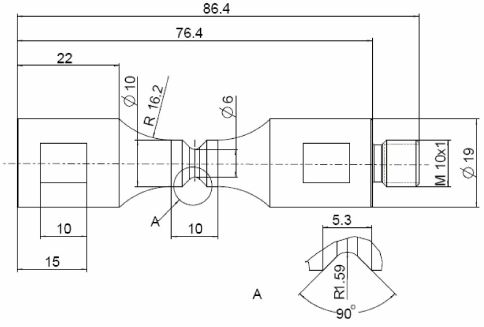
Figure 3. Geometry of ultrasonic testing system (USP) specimens with ultimate tensile strength 919 MPa and K = 1.75 [6], VHF specimens were finalized subsequently [9].